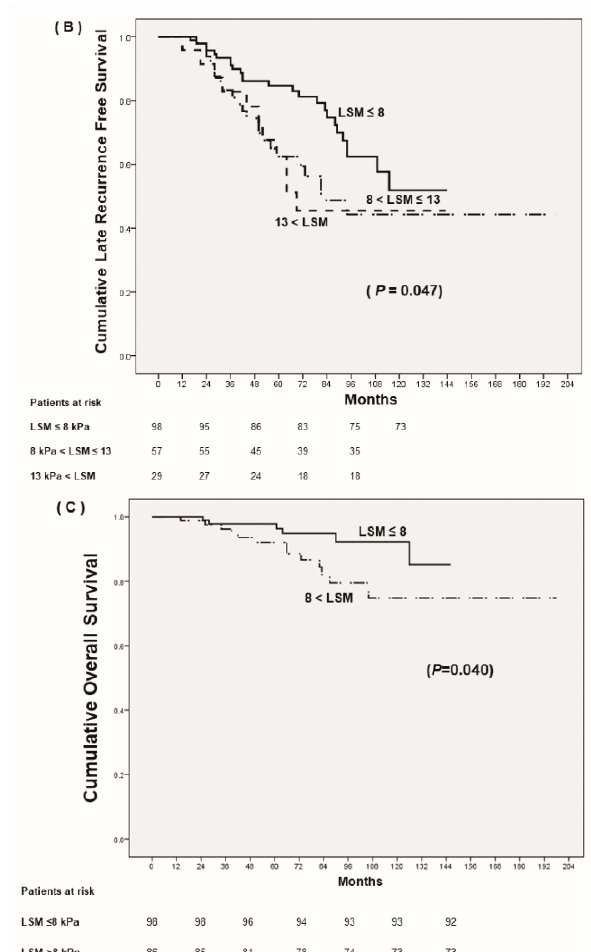
Figure 2. Prognosis of HCC after curative resection according to follow up-liver stiffness measurements (LSM). ( A ) Cumulative late recurrence-free survival based on stratified LSM, ≤ 8 kPa vs. >8 kPa. ( B ) Cumulative late recurrence-free survival based on stratified LSM, ≤ 8 kPa vs. 8 kPa < LSM ≤ 13 kPa vs. >13 kPa. ( C ) Cumulative overall survival.